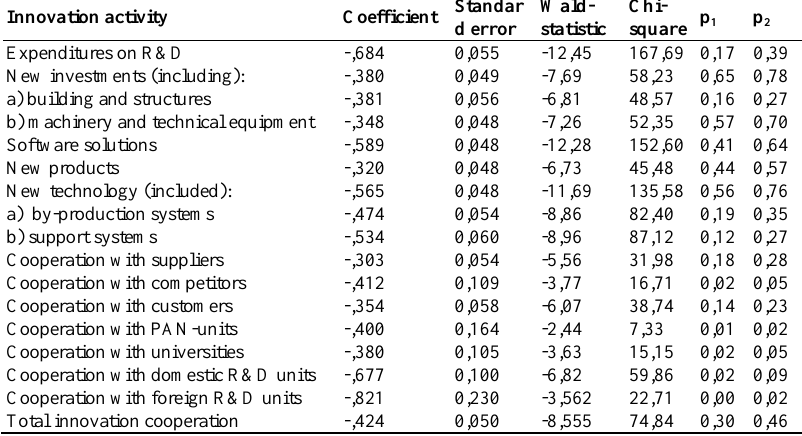
Table 1. Coefficient value by independent variable „local range”, in probit models describing innovation activity in the polish manufacturing system (statistical